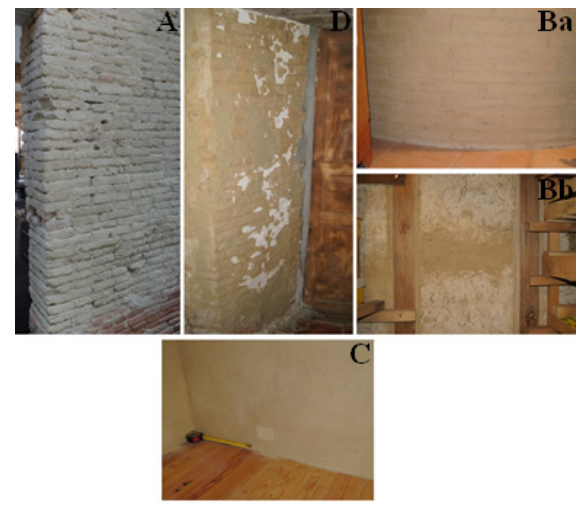
Figure 3. Earthen building sampling sites.